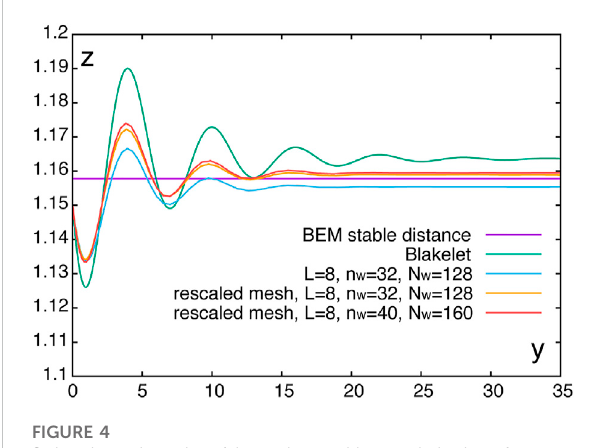
FIGURE 4 Swimmingtrajectoriesofthesquirmerwitharegularisation of ϵ = 0.001 and different discretisation parameters. Also plotted is the height of the stable fi xed point obtained by the boundary element method using the singular Blakelet (Ishimoto and Gaffney, 2013), as labelled “ BEM stable distance, ” and a trajectory using a regularised Blakelet with the nearest-neighbour regularised Stokeslet method, as labelled by “ Blakelet. ”